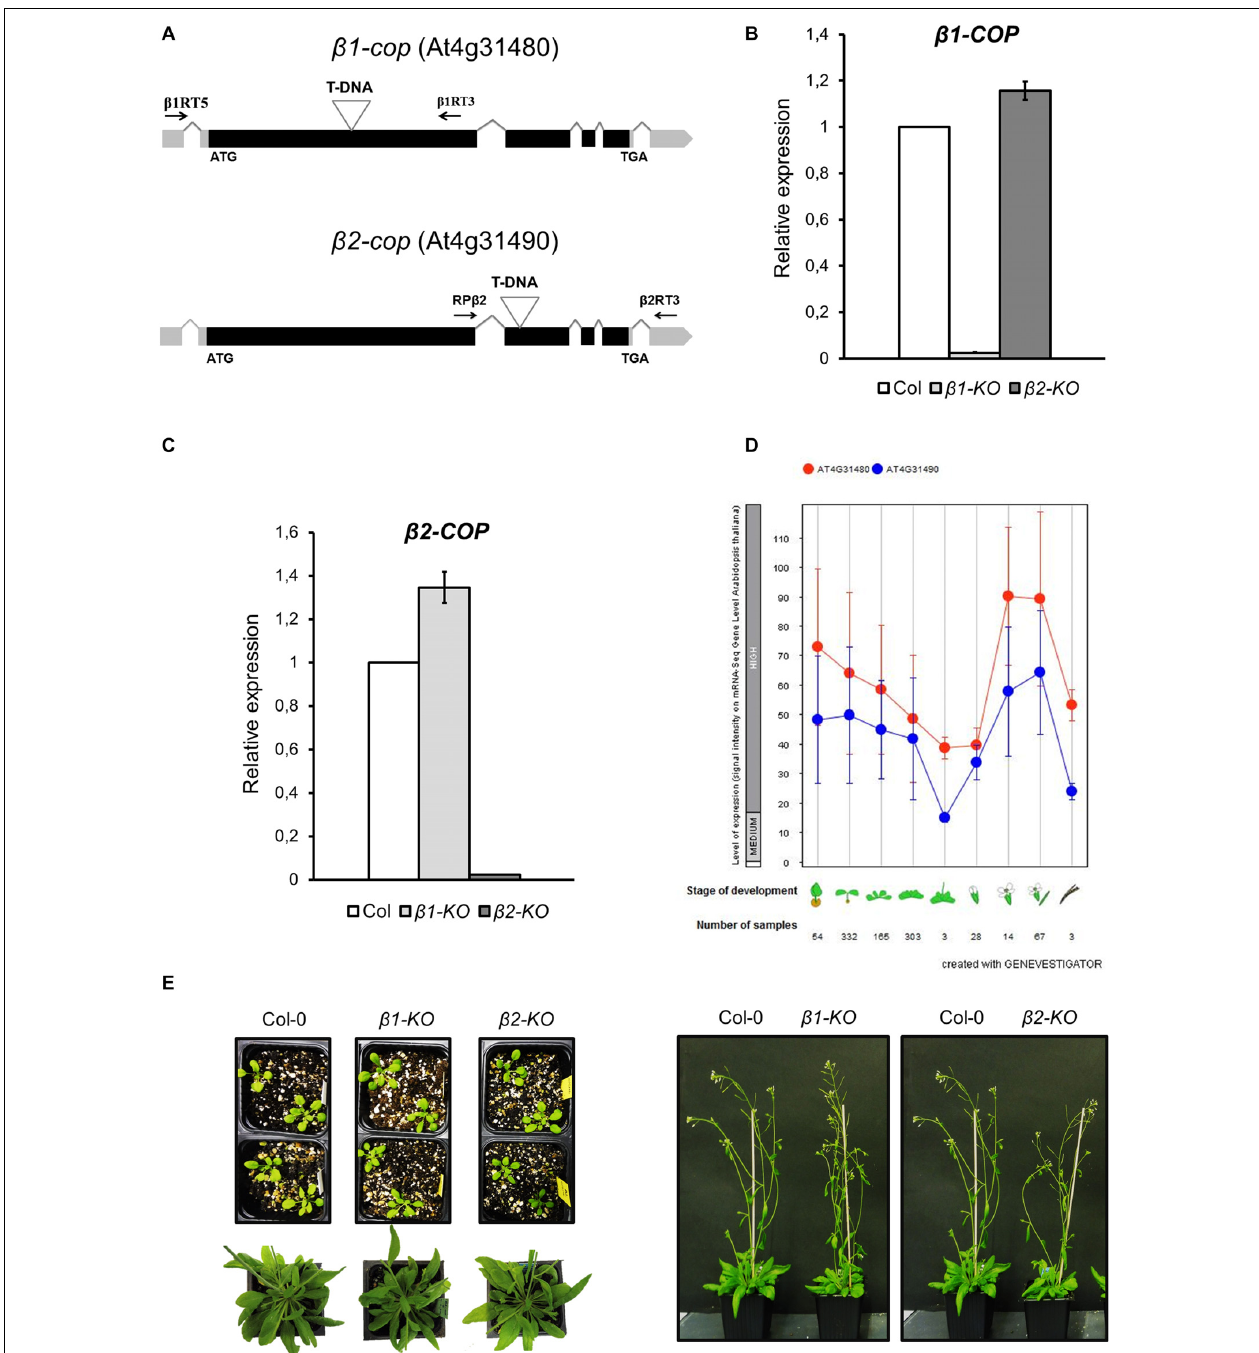
FIGURE 2 | Characterization of β 1-cop and β 2-cop mutants. (A) Diagram of β 1-COP and β 2-COP genes and localization of the T-DNA insertion (triangle) in the mutants. Black boxes represent coding regions and gray boxes represent 5 (cid:48) UTR and 3 (cid:48) UTR regions. The positions of β 1RT and β 1RT3 primers and RP β 2 and β 2RT3 primers used to genotype β 1-cop and β 2-cop mutants, respectively, are shown by arrows. (B,C) RT-qPCR analysis to show the absence of β 1-COP (B) and β 2-COP (C) mRNA in the β 1-cop and β 2-cop mutants, respectively. Total RNA was extracted from 4 days seedlings of the mutant and wild type (Col-0). The mRNA was analyzed by RT-qPCR with specific primers and normalized to UBQ10 expression ( Supplementary Table S2 ). Results are from three biological samples and three technical replicates. mRNA levels are expressed as relative expression levels and represent fold changes of mutant/wild type. Values represent mean ± s.e.m. of the three biological samples. (D) Developmental stage-specific expression patterns of β 1-COP and β 2-COP . Seedlings, rosette leaves, floral organs and siliques are sequentially marked from left to right. “HIGH,” “MEDIUM,” and “LOW” expression were calculated by RNA-seq assay. The number of samples indicates RNA-seq gene expression data collected by GENEVESTIGATOR (www.genevestigator.com). (E) β 1-cop and β 2-cop mutants did not show any phenotype different from wild type.